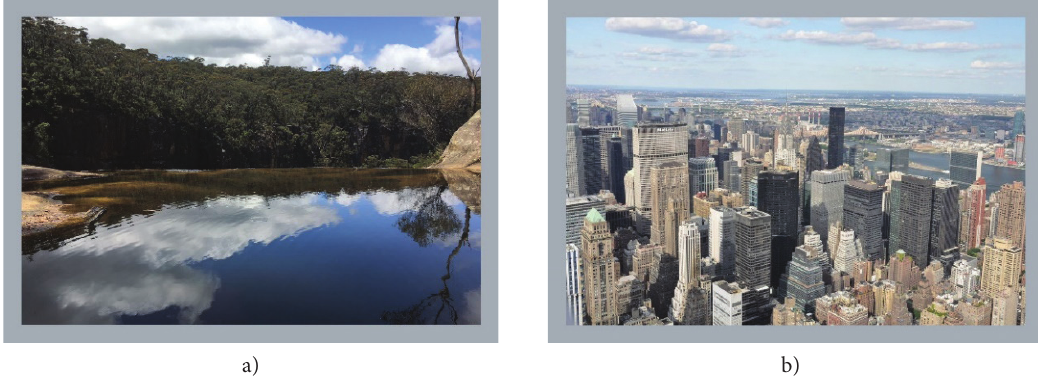
Figure 2. Examples of natural and urban view with minor negative characteristics: a) View 4 includes natural elements such as forest, clouds, and water. Being away prevail. Negative characteristics such as closed view and absence of illegibility is evident; b) View 26 is a high view of the metropolis where fascination and Lynch’s visual quality singularity prevail. Absence of being away, and Lynch’s visual quality clarity of joint as well as absence of natural elements is